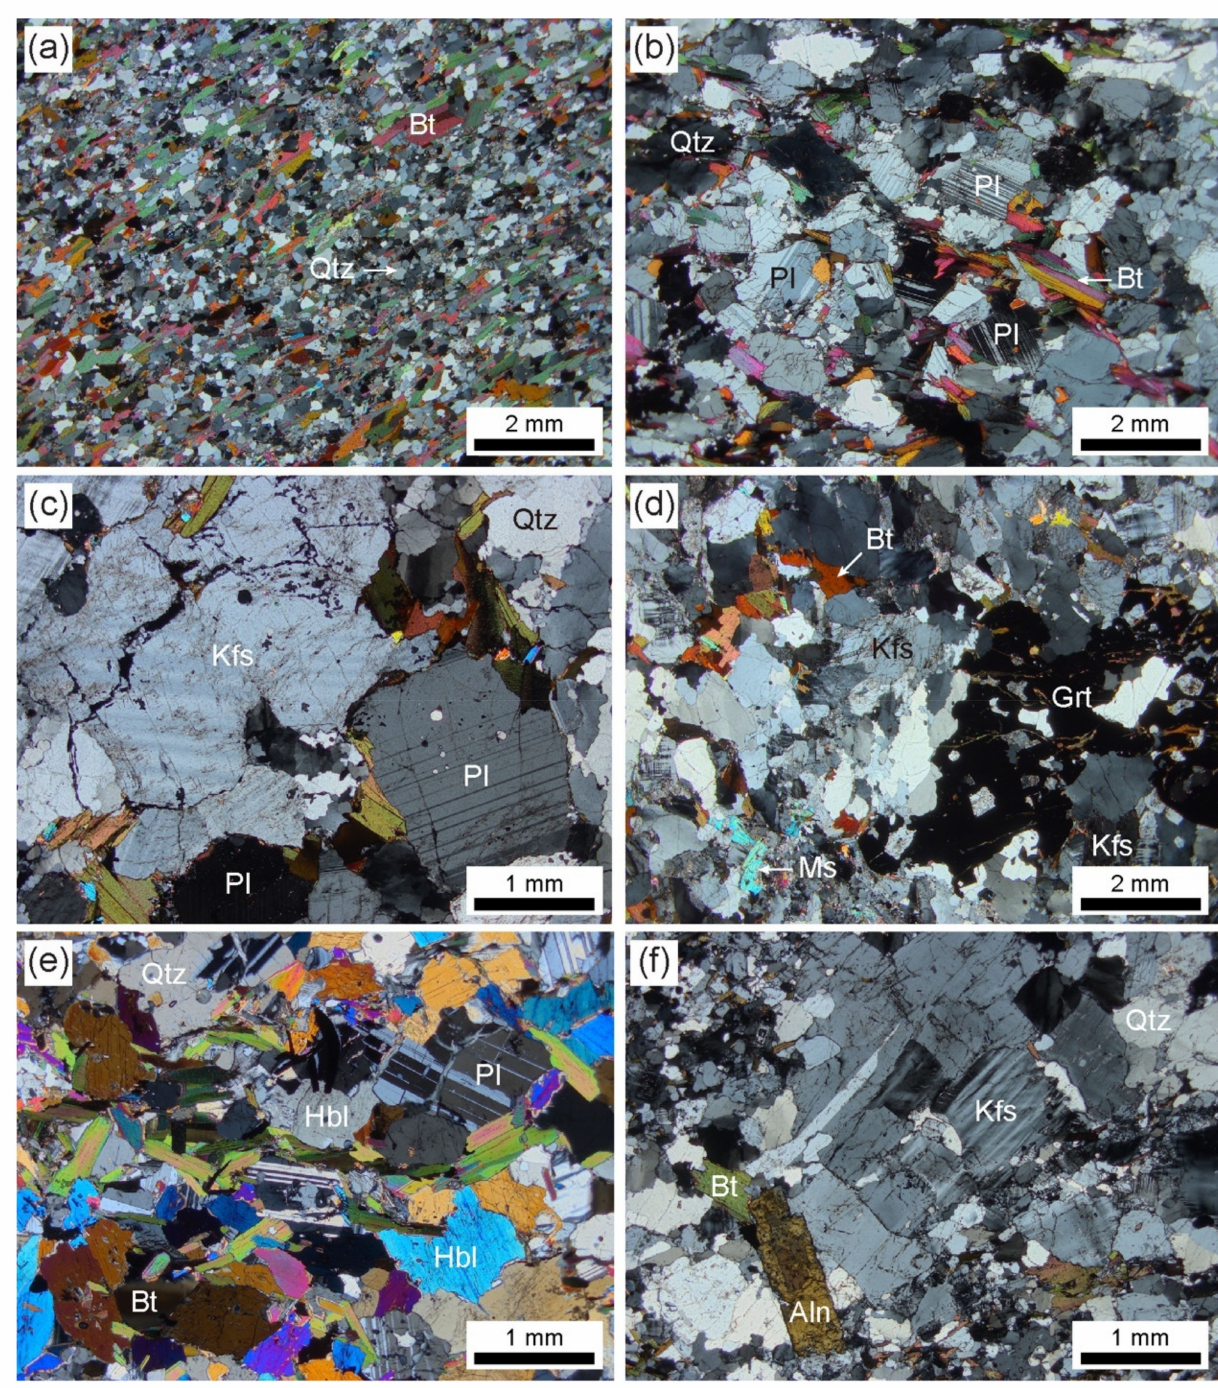
Figure 4. Photomicrographs of the studied rocks displaying ( a ) fine-grained flakes of biotite aligned subparallel to the foliation in biotite schist of the Wilson Metamorphic Complex, ( b ) quartz grains exhibiting sutured boundaries and undulatory extinctions in a migmatitic gneiss of the Wilson Metamorphic Complex, ( c ) the Browning foliated porphyritic granite showing fractures in plagioclase and K-feldspar, ( d ) poikilitic garnet in the Browning leucocratic granite, ( e ) the Campbell gabbroic diorite containing hornblende, plagioclase, and biotite, characterized by an equigranular texture, and ( f ) the Campbell biotite granite without a foliated texture. Photos were taken under a cross-polarized light. Bt: biotite; Qtz: quartz; Pl: Plagioclase; Kfs: K-feldspar; Grt: garnet; Ms: muscovite; Hbl: hornblende; Aln: